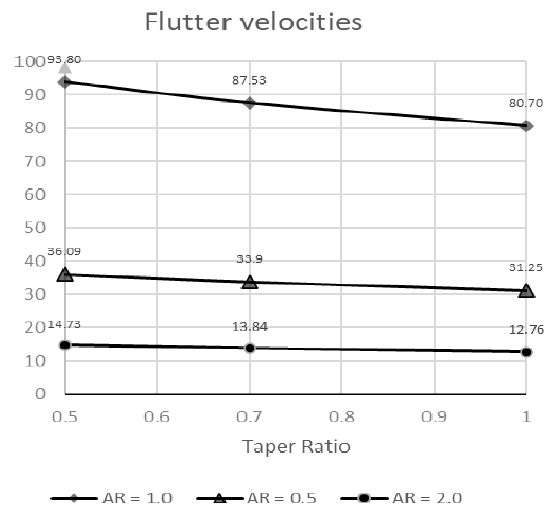
Figure11. Flutter velocity as a function of Taper Ratio